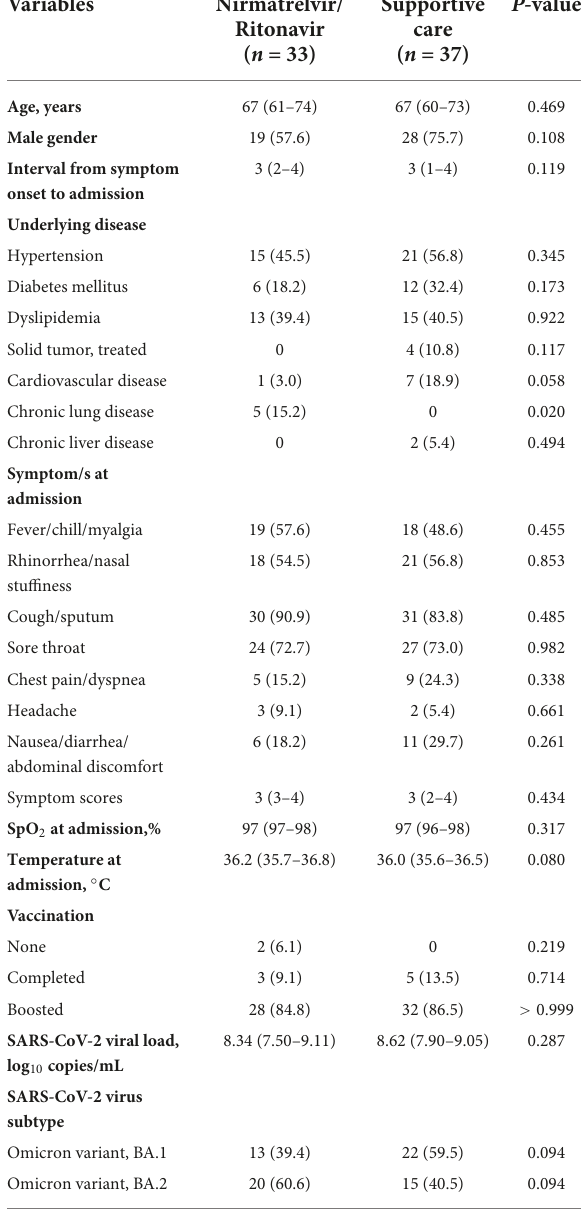
TABLE 1 Clinical characteristics of the mildly ill COVID-19 study patients.